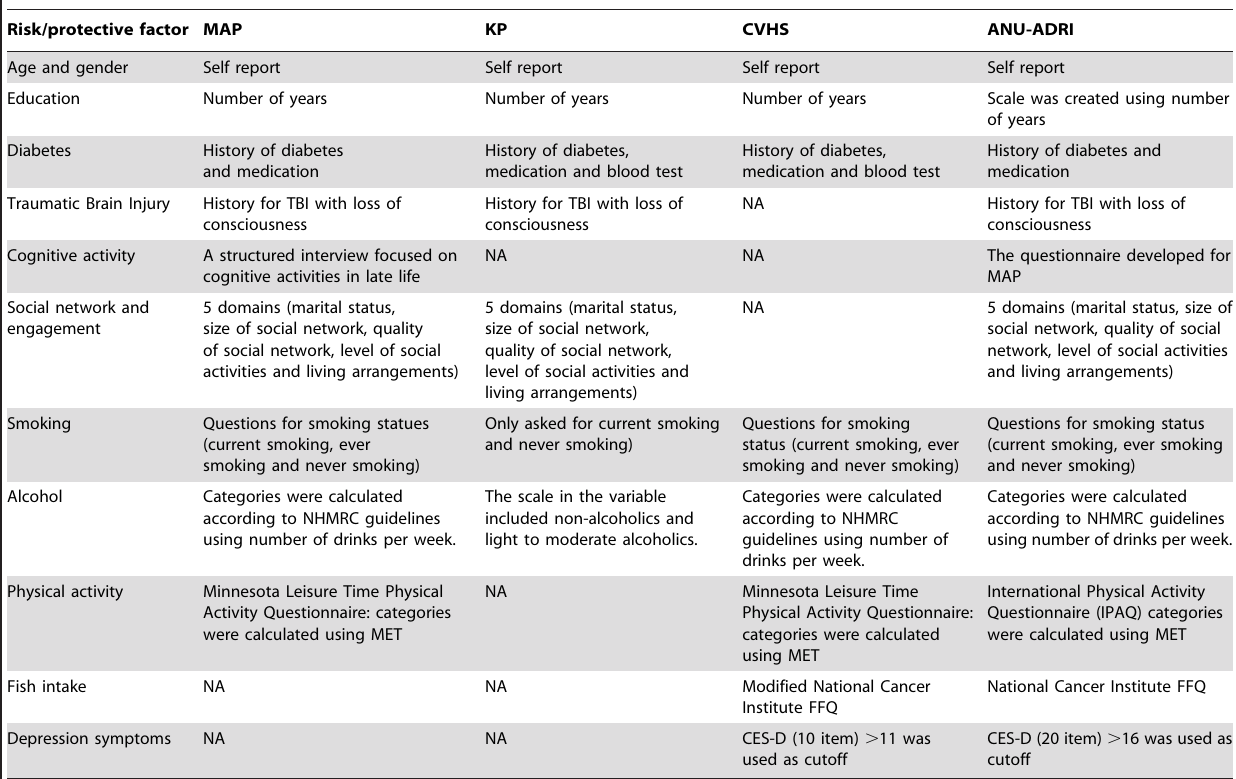
Table 1. Risk and protective factors included from each